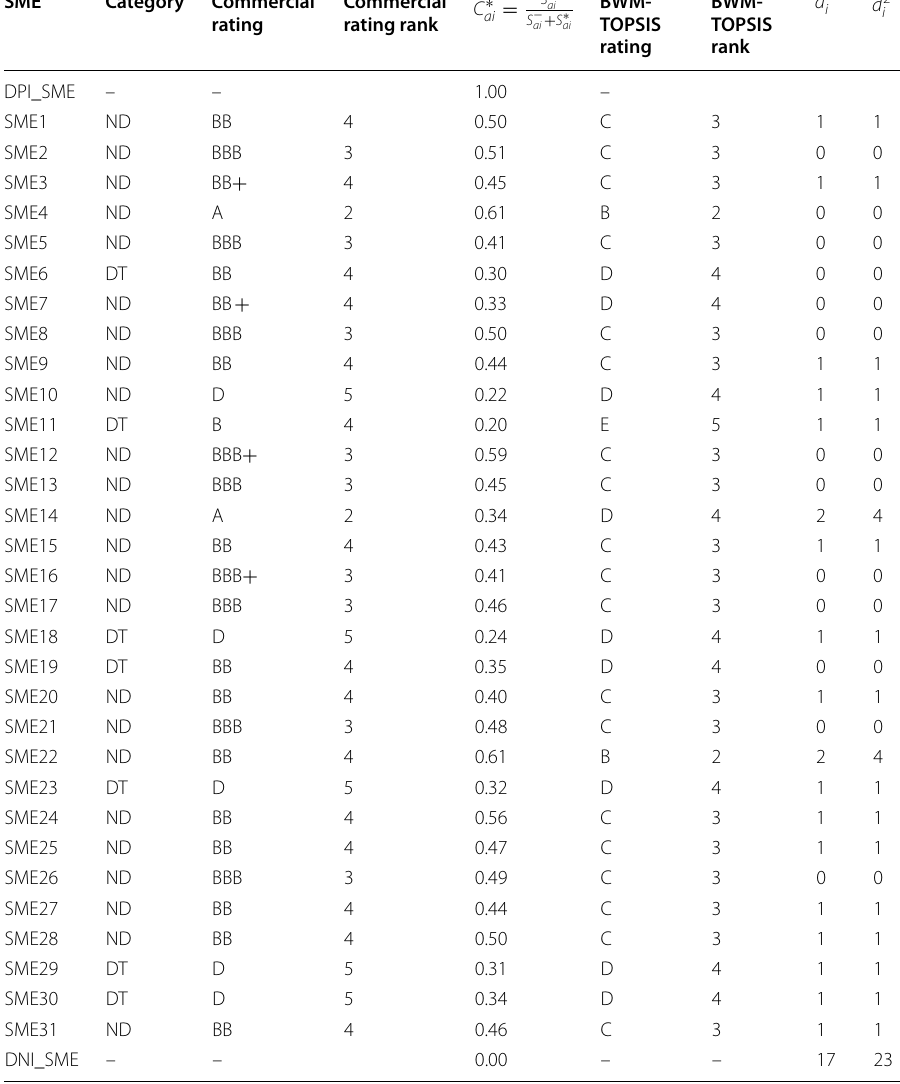
Table 11 Final credit score and rating of the selected SMEs based on closeness index